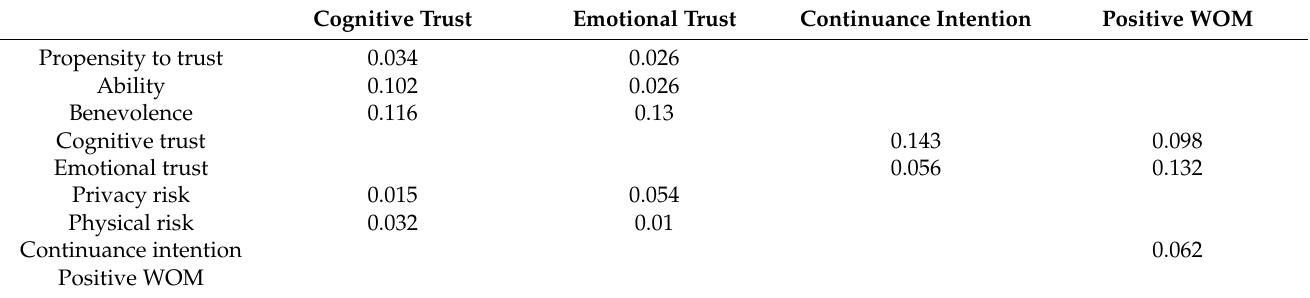
Table 9. Results of f 2